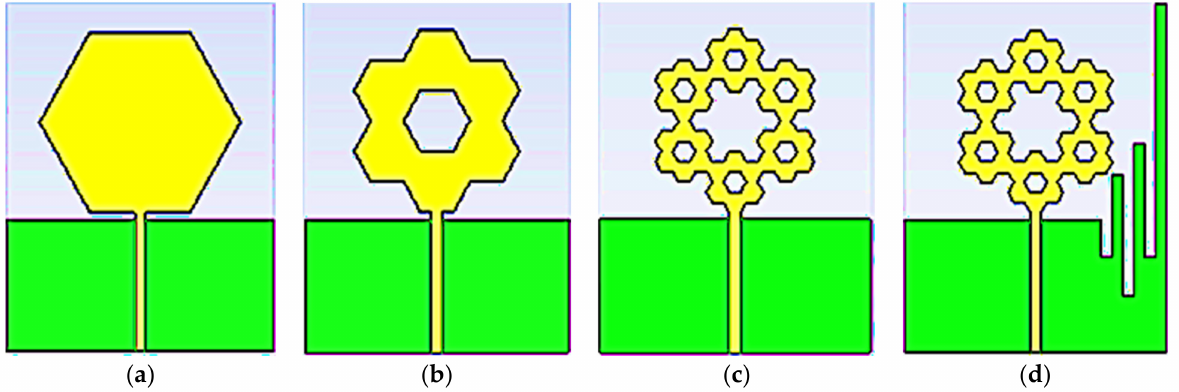
Figure 2. Evolution mechanism of the developed Sierpinski hexagonal-shaped fractal antenna: